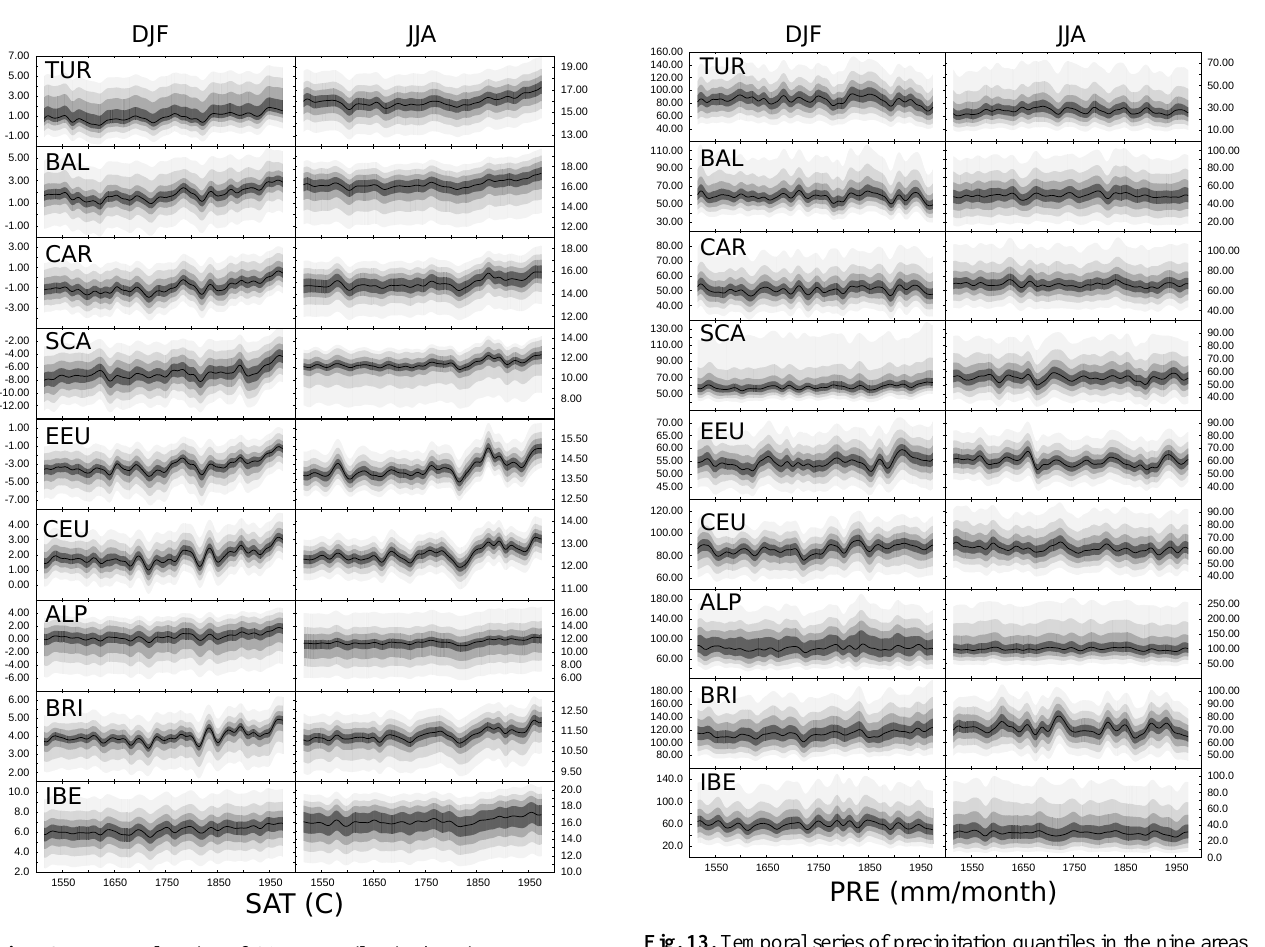
Fig. 12. Temporal series of SAT quantiles in the nine areas con- sidered in Fig. 2. The filled curves with different grey shading en- compass the percentiles between 10 and 90 of the SAT field in each time step, while the solid line represents the median. The series are smoothed through a Hamming window of 30 time steps to empha- sise the low-frequency variability and facilitate the visualization.